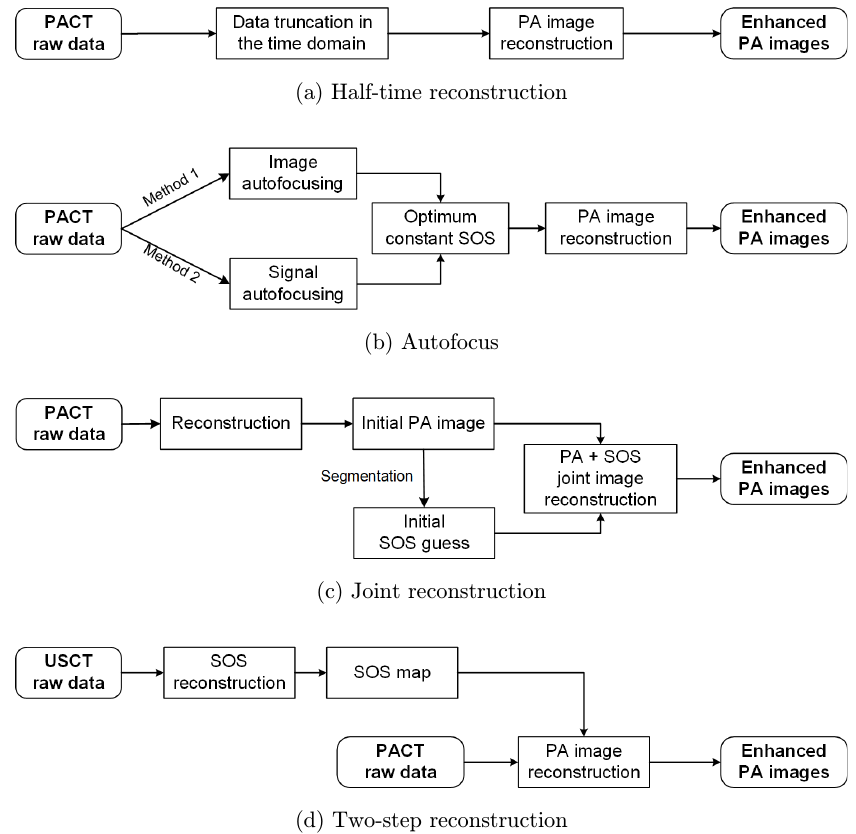
Fig. 2. Working procedure of the four methods for mitigating acoustic heterogeneity in PACT.